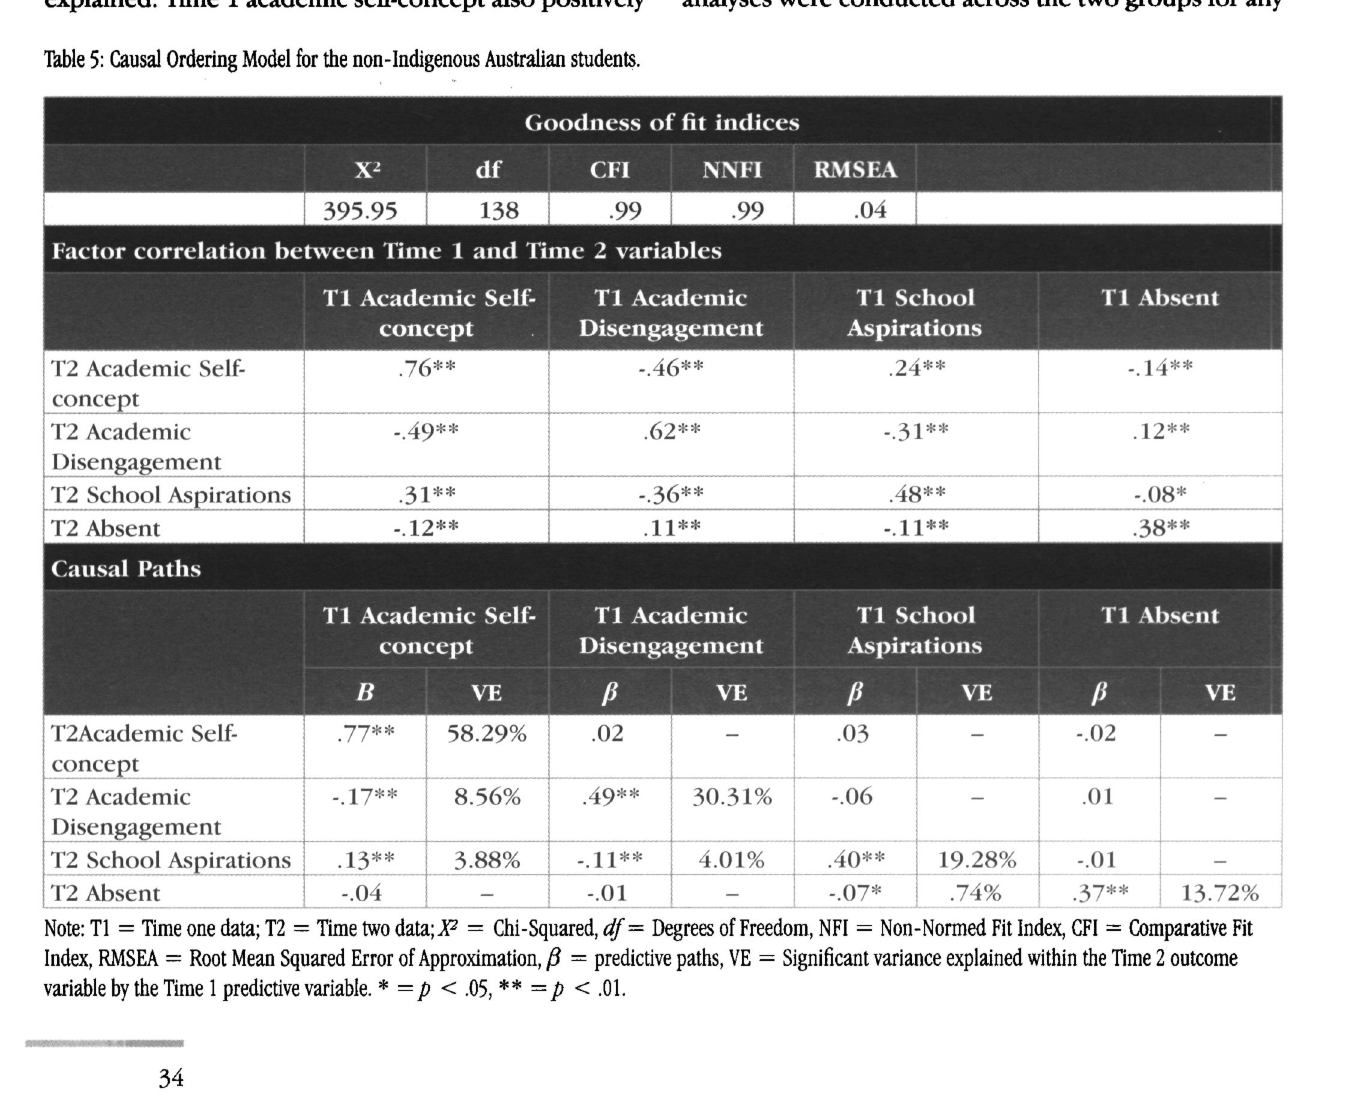
Table 5: Causal Ordering Model for the non-Indigenous Australian